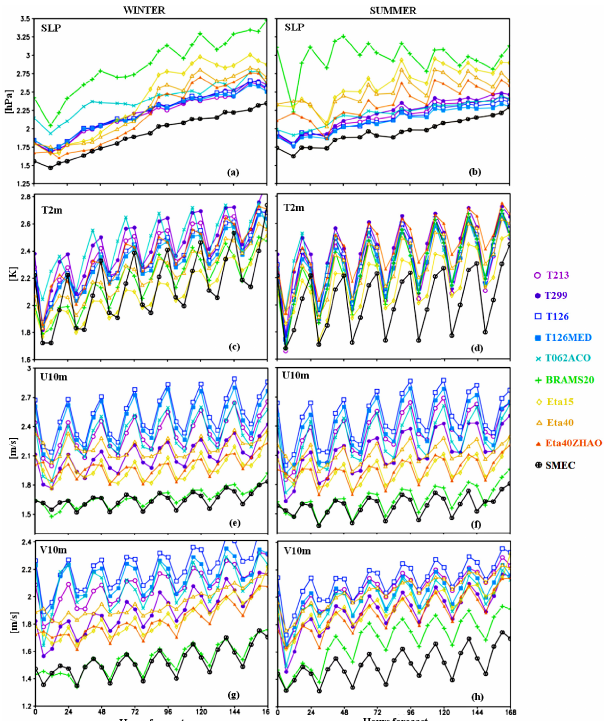
Figure 10. Time evolution of the spatial mean of the RMSE (cal- culated with respect to observations) of mean sea level pressure (a, b) , temperature at 2m (c, d) , zonal wind at 10m (e, f) , meridional wind at 10m (g, h) for the winter (left column) and summer (right column)